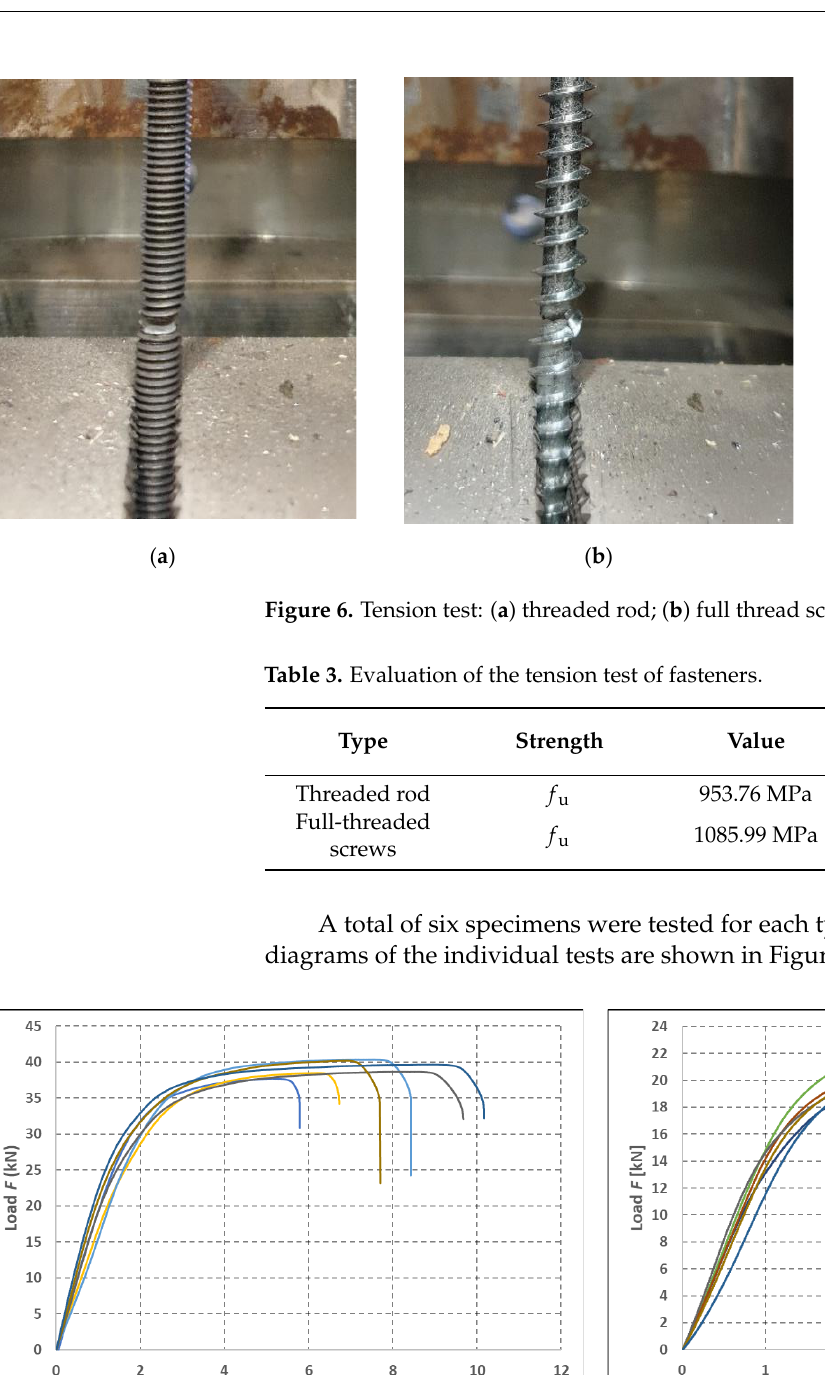
Figure 7. Load – displacement diagrams of fasteners: ( a ) threaded rods; and ( b ) full-threaded bolts. Tensile strength in the range of 912.88 MPa–977.96 MPa was achieved in the case of bolts. The course of the loading was very similar for all specimens. The area of linear